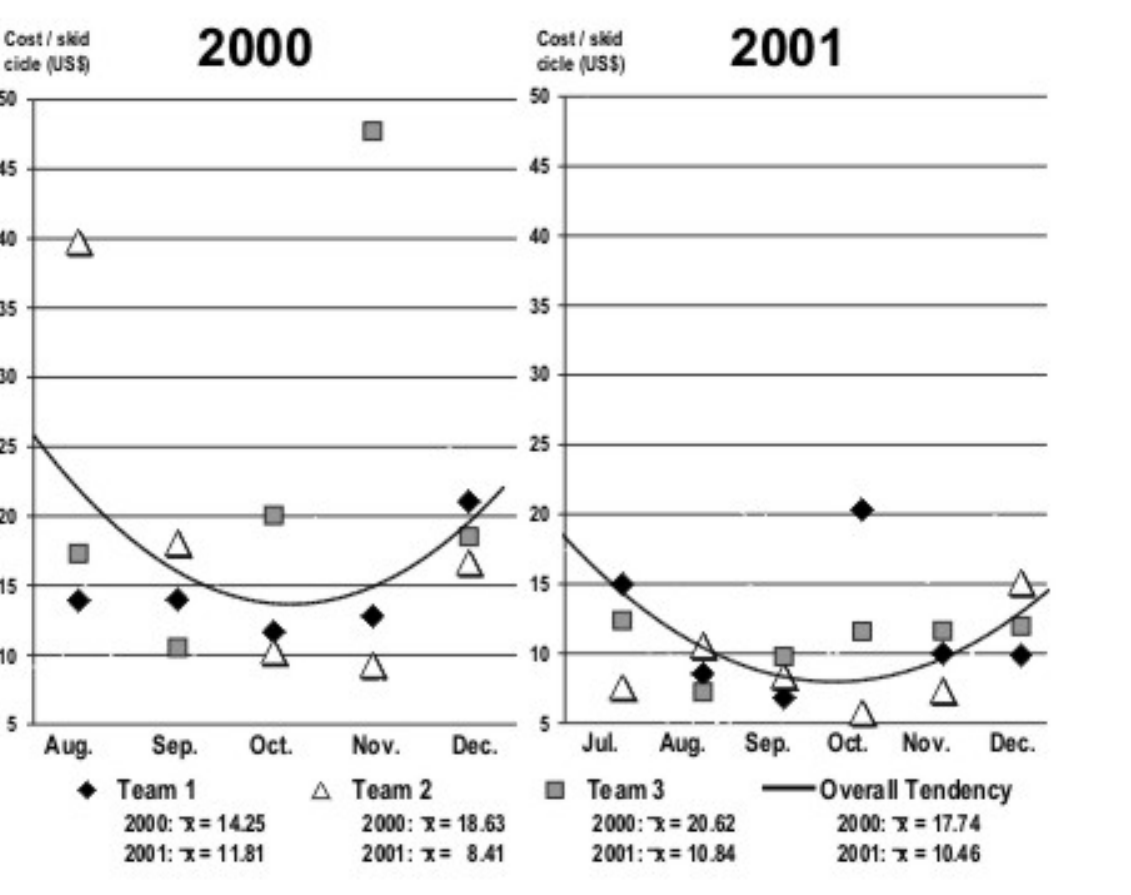
Fig. 5 . Costs for skidding a log during the harvest periods 2000 and 2001, affected by the implementation of planned skidding as part of RIL in September